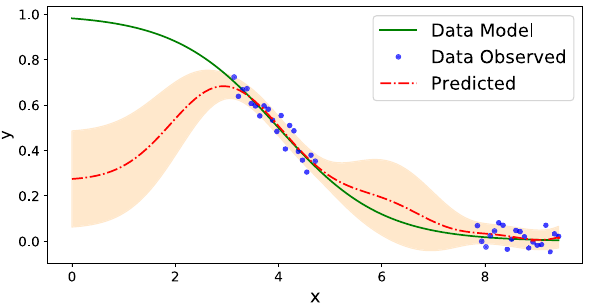
Figure 2. Example of Gaussian process regression (red dashed line stands for the predictive mean and orange fill stands for the standard deviation intervals) with noisy measurements (blue dots) of a sigmoid function (solid green line) using Gaussian kernel and constant mean